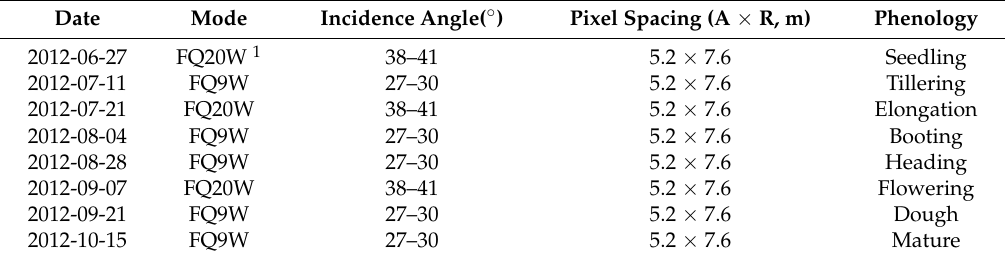
Table 1. Available RADARSAT-2 images and corresponding rice phenology stages. Date: